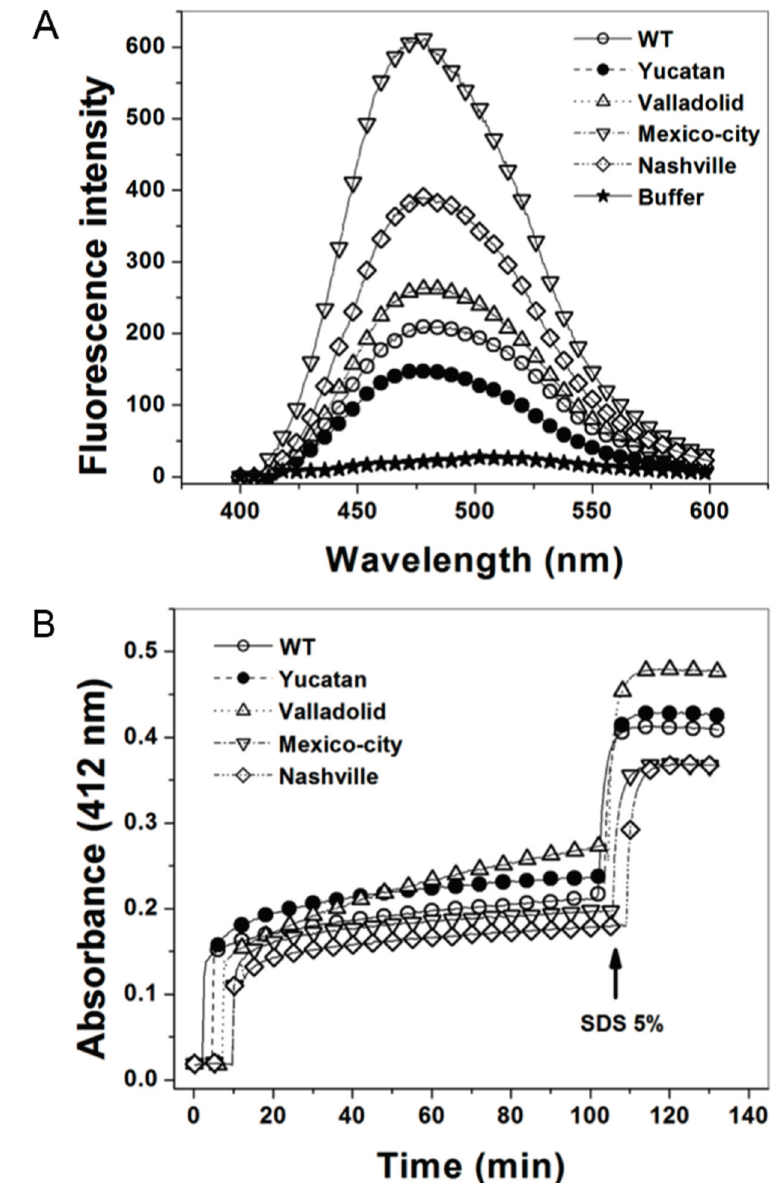
Figure 6. 8-Anilinonaphthalene-1-sulphonate (ANS) and 5,5'-dithiobis-2-nitrobenzoic acid (DTNB) accessibility assays of WT G6PD and the four clinical variants. ( A ) ANS fluorescence spectra of WT G6PD and the four clinical mutants were obtained using an excitation wavelength of 395 nm and recording emission spectra from 400 to 600 nm; the final concentrations of ANS and enzyme were 165 μ M and 400 μ g/mL, respectively. Values obtained from buffer containing ANS without protein (open stars) were subtracted from the recordings with protein; and ( B ) The derivatization of Cys residues in G6PD (200 µg/mL) in 1 mM DTNB was followed spectrophotometrically at 412 nm. The arrow indicates the time of addition of 5% SDS, after which the number of Cys per monomer was calculated for the enzymes. Each trace is the average of two independent